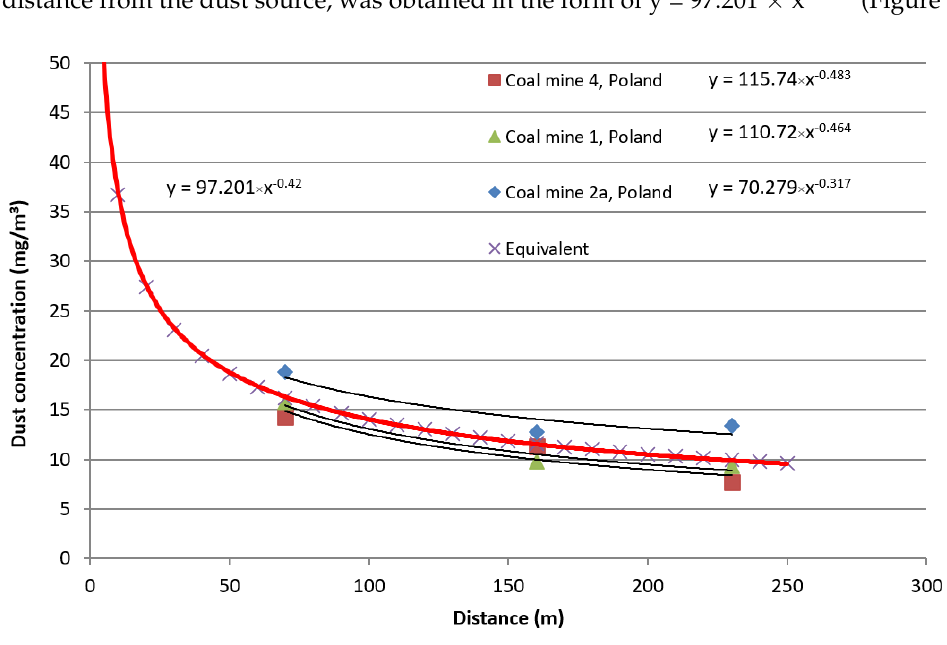
Figure 15. Equivalent characteristics of PM10 dust concentration (measured by the Pł-2 dust meters), depending on the distance from the dust source, determined on the basis of dust concentration measurements in three gates.